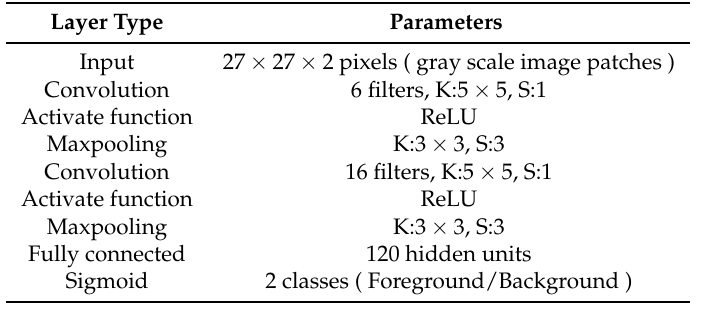
Table 2. The structure of the adopted convolutional neural network, where K is the size of the kernel, S is the stride [16].